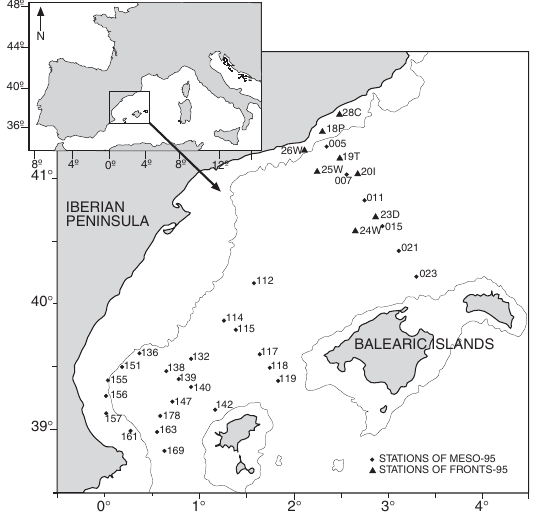
F IG . 1. – Position of the sampled stations during the year 1995 (Cruises Meso-95 and Fronts-95). It is enclosed the general map of the western Mediterranean showing the location of the studied